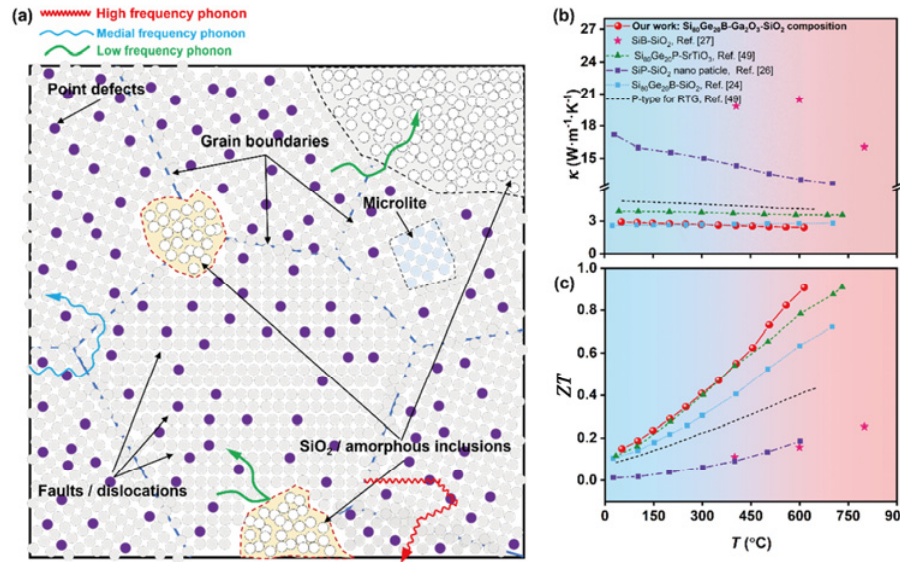
Fig. 1 (a) Schematic of hierarchical structure for the suppression of κ . (b) κ and (c) ZT values for comparing with the corresponding counterparts of insulative-oxide-composited Si-based TE